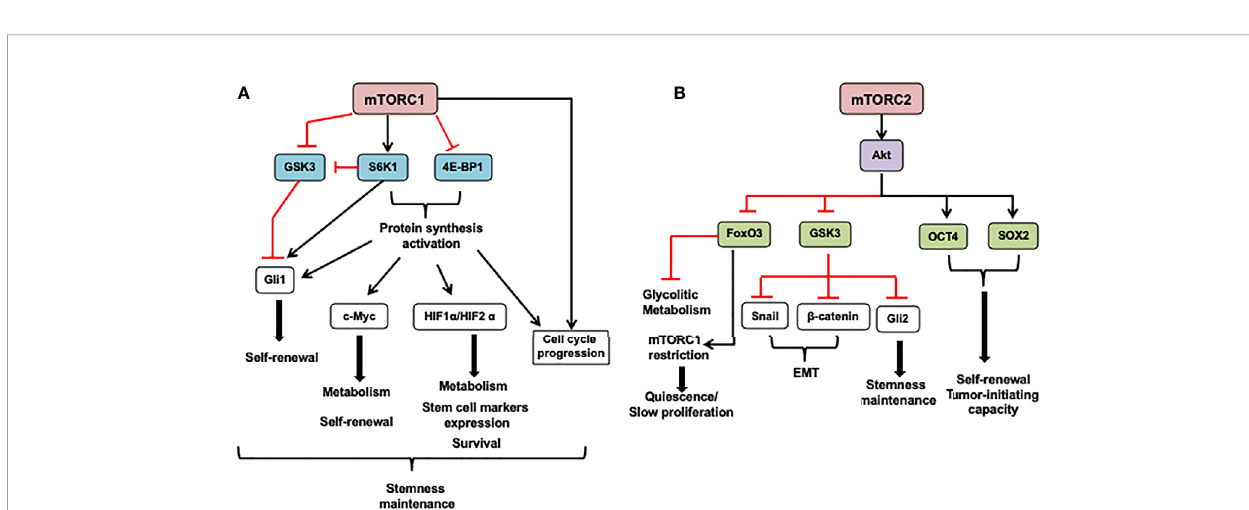
FIGURE 3 | mTOR in cancer stem cells (CSCs). (A) The mTORC1 can modulate cell metabolism, cell survival, proliferation, and stem cell maintenance mostly through protein synthesis activation of transcription factors that induce the expression of genes coding proteins involved in these functions. Also, mTORC1 can promote Gli1 (downstream effector of the Hedgehog pathway), nuclear localization through its effector S6K1 that induces Gli1 releasing from its endogenous inhibitor, SuFu, and inhibits GSK3-mediated its degradation. Besides, mTORC1 under mitogenic signals and amino acid availability controls GSK3 nuclear import and, in turn, its nuclear functions as mediating c-Myc degradation. (B) The role of the mTORC2 complex in CSCs is mainly mediated by its effector Akt. This protein can phosphorylate many substrates, including OCT4 and SOX2, transcription factors that regulate stem cell self-renewal and promote pluripotency. Akt directly phosphorylates these transcription factors increasing its stability and triggering its nuclear import. Also, Akt inhibits GSK3, leading to GSK3 substrates stabilization such as b -catenin and Snail implicated in epithelial- mesenchymal transition (EMT) and Gli2 that increases SOX2, OCT4, and Nanog expression in CSCs. FoxO3 inhibition by mTORC2 signaling through Akt activation and HDACs inhibition avoid FoxO3 nuclear localization and FoxO3 deacetylation, respectively. It might release FoxO3-induced c-Myc repression, promoting upregulation of glycolytic metabolism. 4E-BP1, eukaryotic translation initiation factor 4E binding protein 1; FoxO3, forkhead box O3; GSK3, Glycogen synthase kinase; Gli1/2, Glioma- associated oncogene; HIF1 a , hypoxia-inducible factor 1 subunit alpha; S6K1, ribosomal protein S6 kinase; OCT4, octamer-binding transcription factor 4; SOX2, RY-box transcription factor 2. SuFu, SUFU negative regulator of hedgehog signaling. The arrows indicate: ! , activation signals; ┴ , inhibition